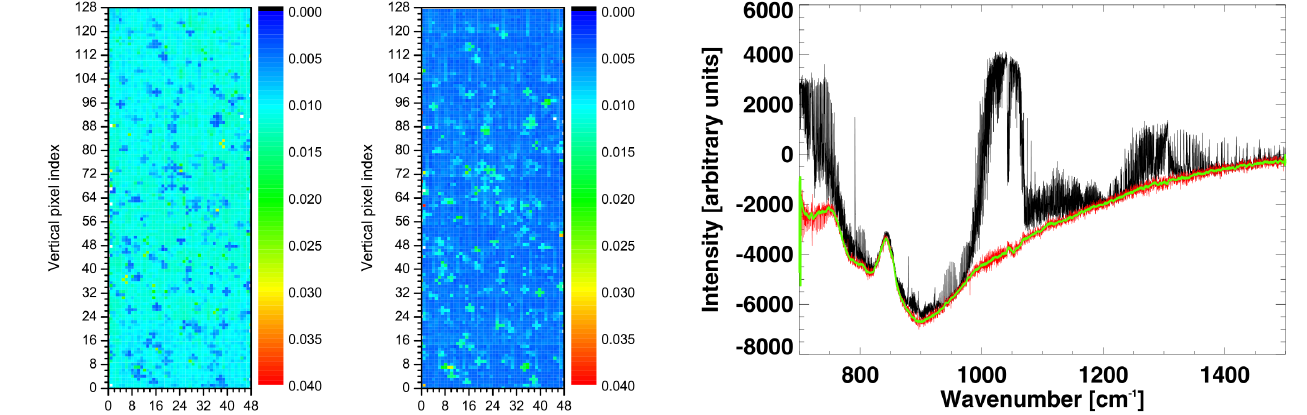
Figure 5. Mean signal of a normalised blackbody spectrum in the range between 20 and 400cm − 1 before (left) and after nonlinear- ity correction (right). The colour code denotes the relative intensity (the maximum of the spectrum is scaled to 1). The intensity of the artefact is clearly reduced after nonlinearity correction for most of the pixels.